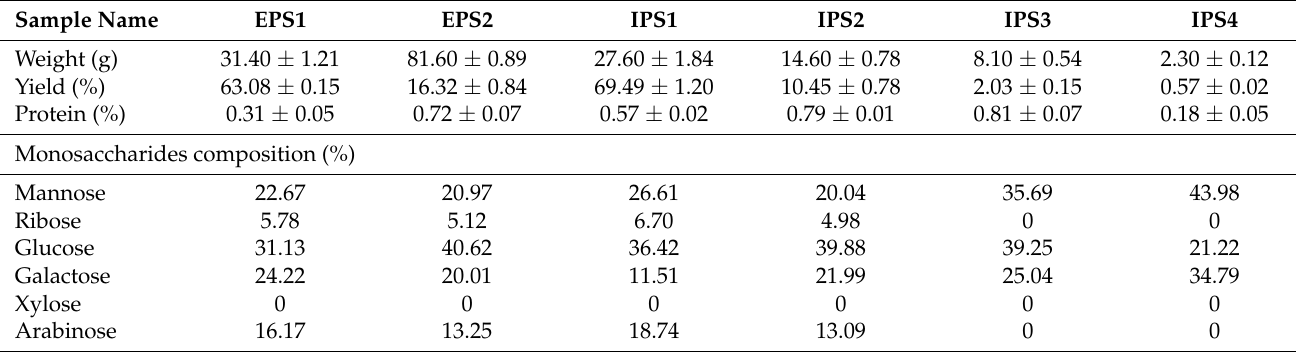
Figure 1. Extraction and purification of the intracellular (IPS) and extracellular (EPS) polysaccharides from the mycelium and culture filtrate of T. harzianum by column chromatography (CC) ( a ), DEAE Sepharose fast flow chromatography-based fractionation of EPS ( b ), and IPS ( c ) using NaCl as a gradient mobile phase. Table 1. Analysis of the biochemical composition of polysaccharides (EPSs and IPSs) isolated from the Trichoderma sp., by spectrophotometric and HPLC assay.